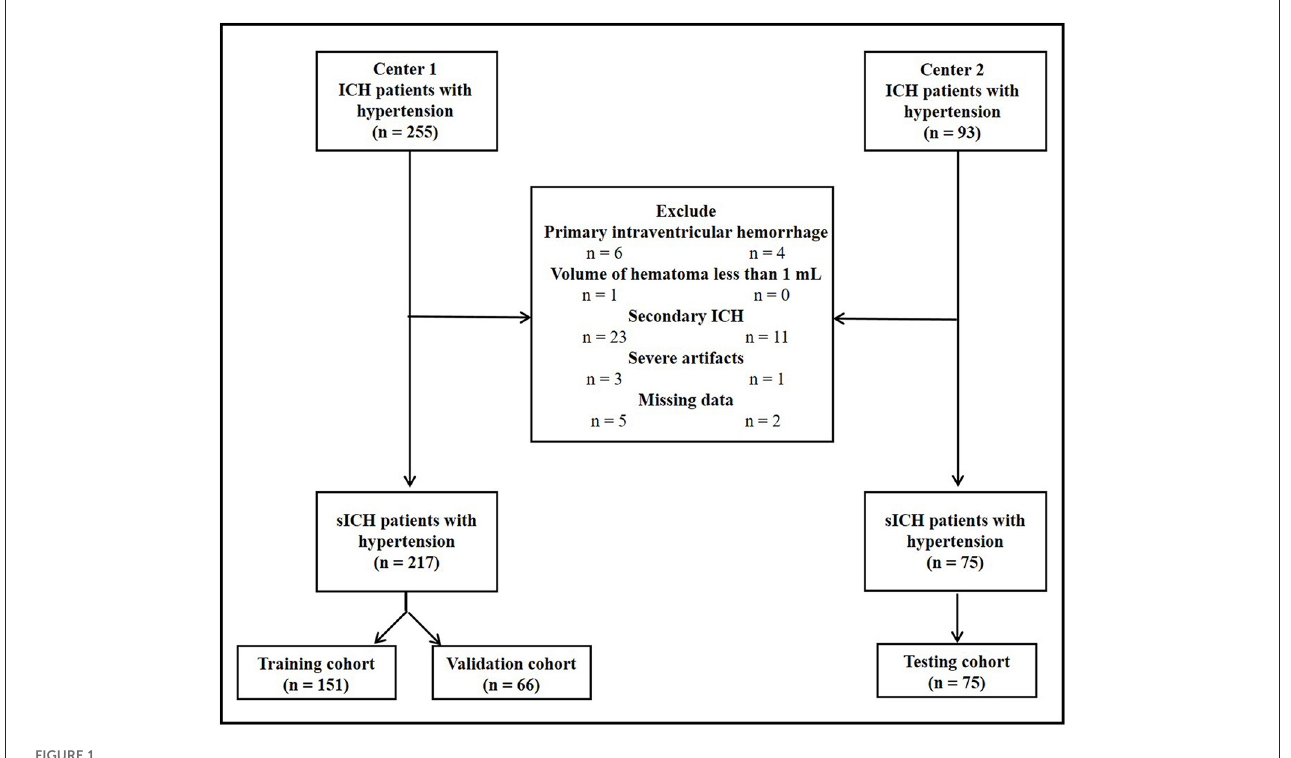
FIGURE1 A flowchart of patient